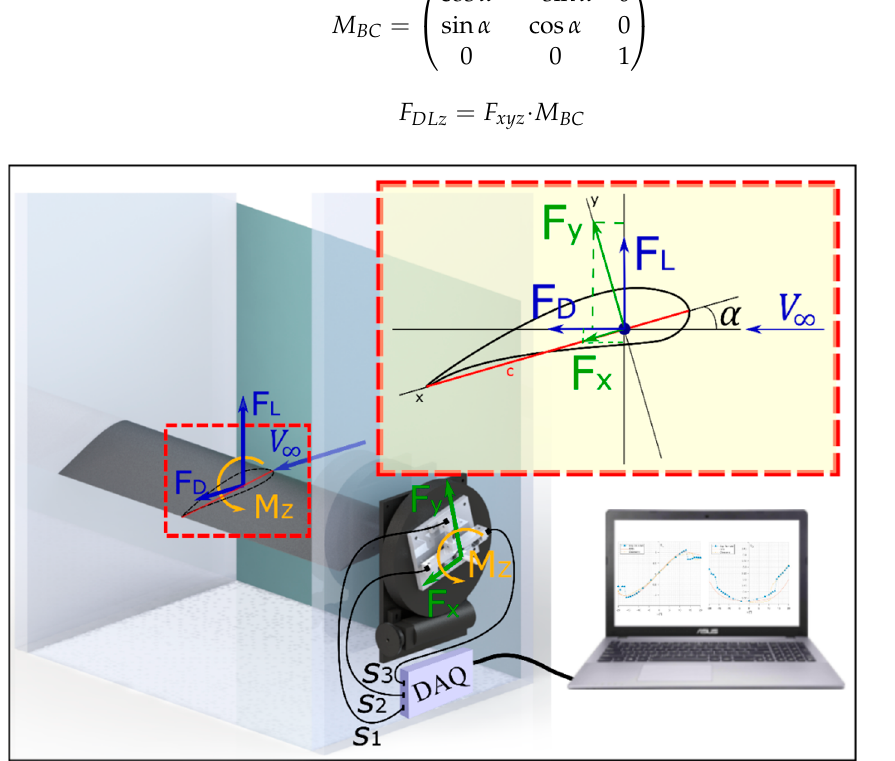
Figure 3. Diagram of the set-up with the variables and the different coordinate systems involved in the measuring